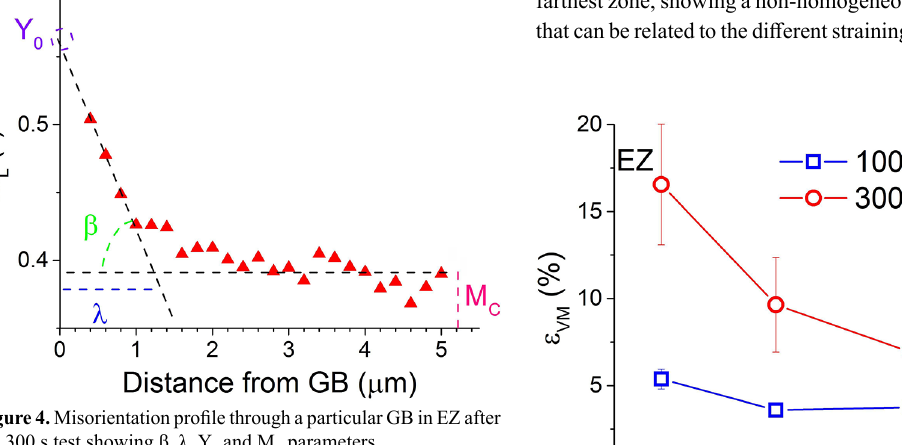
and M parameters. 0 C